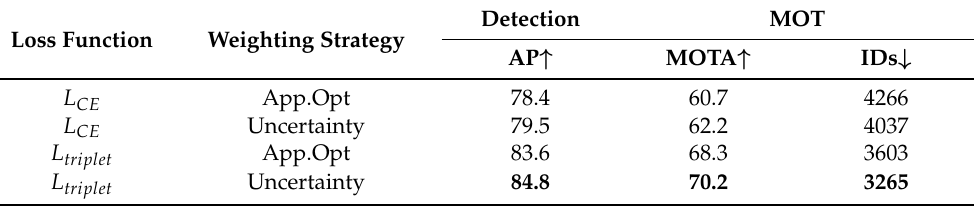
Table 3. Comparing different losses with different loss weighting strategies. App.Opt means using a set of approximate optimal loss weights obtained by cross validation and uncertainty means using task-dependent uncertainty to obtain loss weights as described in Section 4.2. ↓ means the smaller the better; ↑ means the larger the better. In each column, the best result is in bold